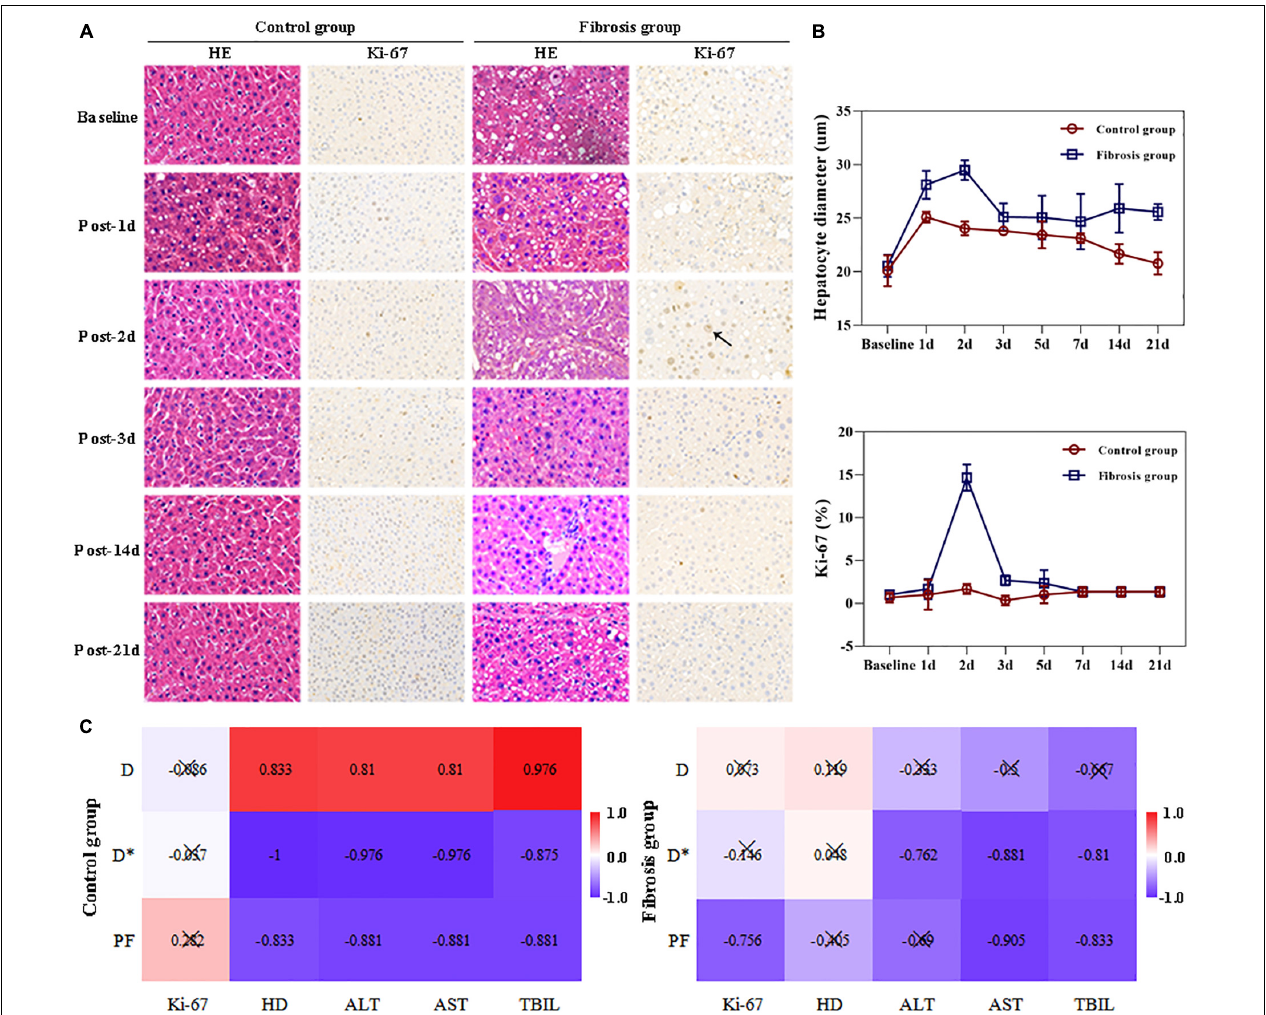
FIGURE 3 | Liver histopathologic changes and correlation analysis. (A) Hematoxylin and eosin stain (HE) showed enlarged hepatocytes post-PH in both the control and fibrosis groups. Immunohistochemical staining of Ki-67 (brown) showed increased Ki-67 + cells (black arrow) in the fibrosis group 2 days after surgery. (B) Changes in hepatocyte diameters and Ki-67 indices post-PH. (C) Correlation hot maps between liver IVIM parameters and LR-related histologic results and liver function biochemical indices. ALT, alanine transaminase; AST, aspartate aminotransferase; HD, hepatocyte diameter; LR, liver regeneration; PH, partial hepatectomy; TBil, total